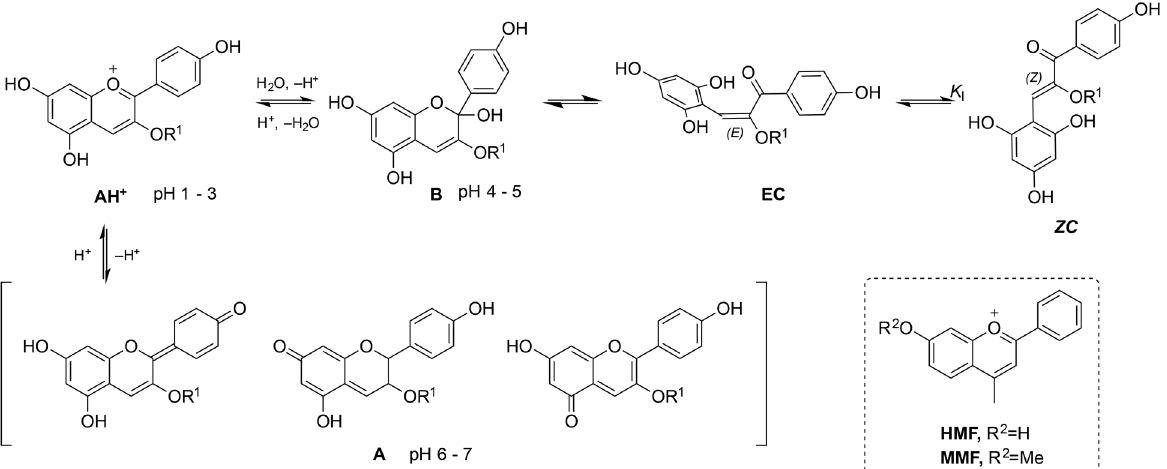
Figure 3 - The pH-dependent multiequilibria of natural anthocyanins, illustrated for pelargonidin monoglyceride (R 1 = glucosyl moiety), together with the chemical structures of the model flavylium cation analogs HMF and MMF used to investigate aspects of anthocyanin chemistry and